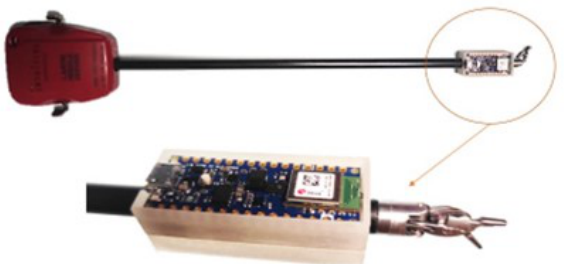
Figure 5. Complete prototype of the first version of the detection device connected to the EndoWrist tool of dVRK system.